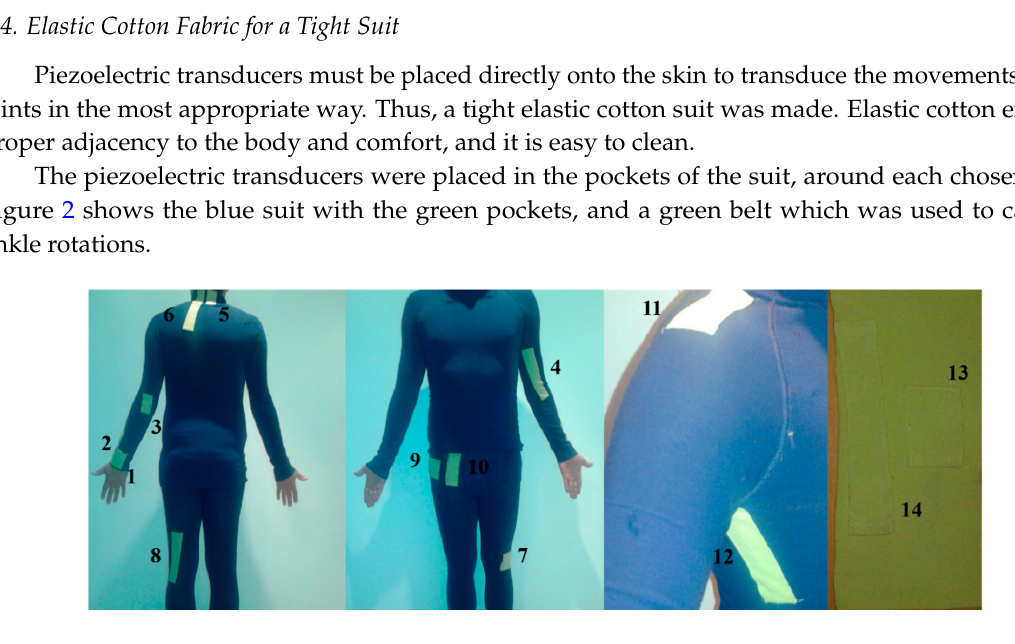
Figure 2. The blue suit with the green pockets and a green belt (please see Table 4 for denotation). parameter, the minimum radius curvature. LDT4-028k is more flexible than P-876.A12, and therefore